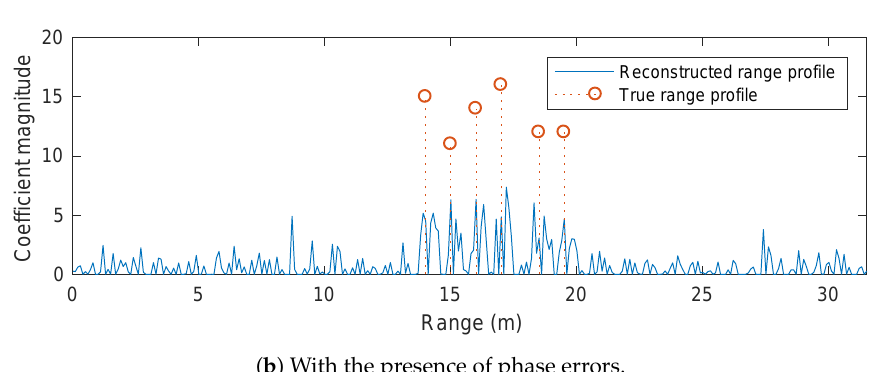
( a ) Without the presence of phase errors.